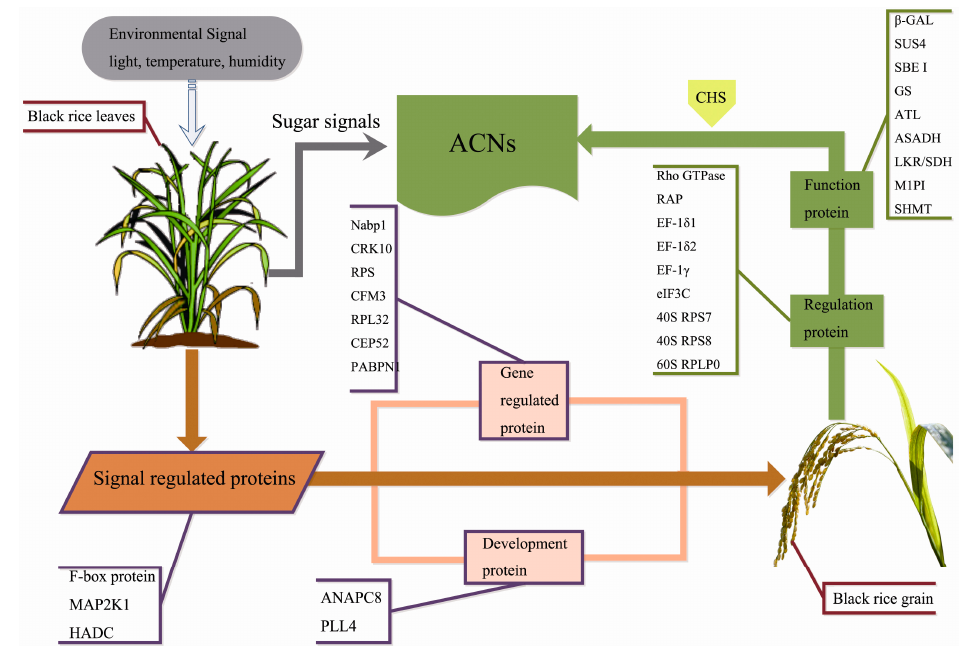
Figure 7. Molecular regulation mechanism of anthocyanin synthesis in the grain filling stage of black rice. In the early stage of grain filling, the regulatory proteins were in an active state of expression in leaf. Signal regulation proteins convert external light, temperature and humidity into intracellular signals that facilitate the expression of proteins that regulate gene expression and development in leaf. The accumulation of these proteins promotes the expression of anthocyanin functional and regulatory proteins, and finally enhances the synthesis of anthocyanin in grains. ACNs, Anthocyanins; Rho GTPase, Mitochondrial Rho GTPase; RAP, Ras-related protein RIC2; EF-1 δ 1, Elongation factors 1-delta